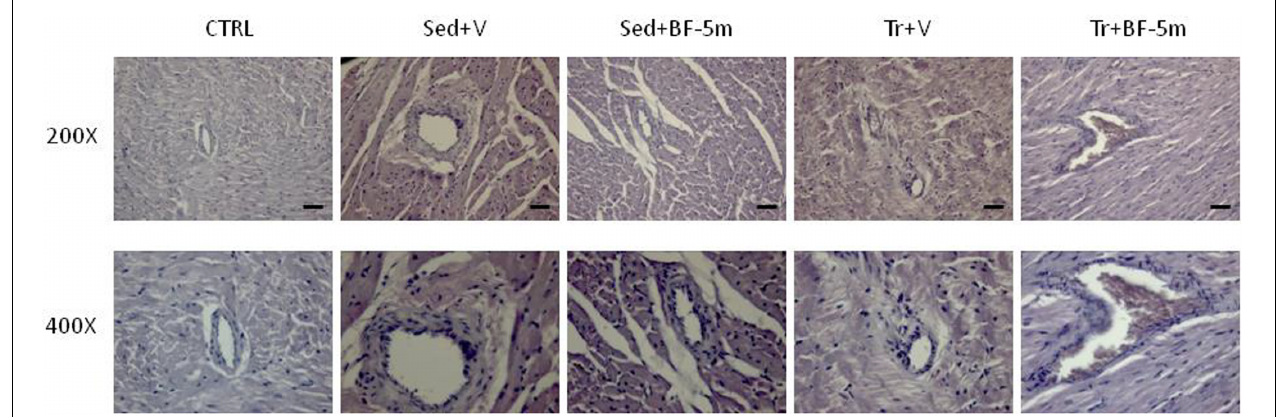
FIGURE 5 | Representative hematoxylin and eosin staining of hearts from healthy control, diabetic sedentary and diabetic trained rats treated with vehicle, BF-5m or vehicle/BF-5m in combination with prolonged (8 weeks total) moderate exercise training ( N = 5 preparations per group). CTRL, healthy control rats; Sed+V, diabetic sedentary rats treated with vehicle; Sed+BF-5m, diabetic sedentary rats treated with BF-5m 20 mg/kg/day; Tr+V, diabetic trained rats treated with vehicle; Tr+BF-5m, diabetic trained rats treated with BF-5m 20 mg/kg/day; Scale bar = 100 µ